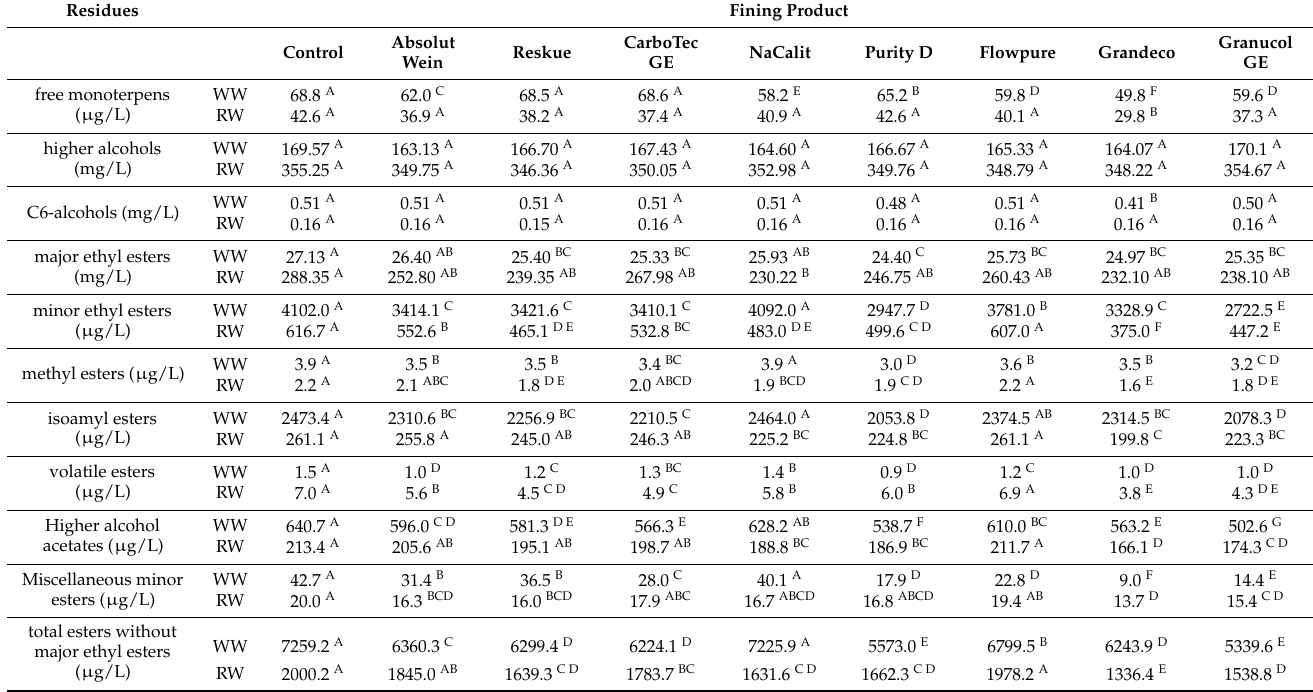
Table 8. Concentration of volatile sum parameters before and after treatment with different fining agents.